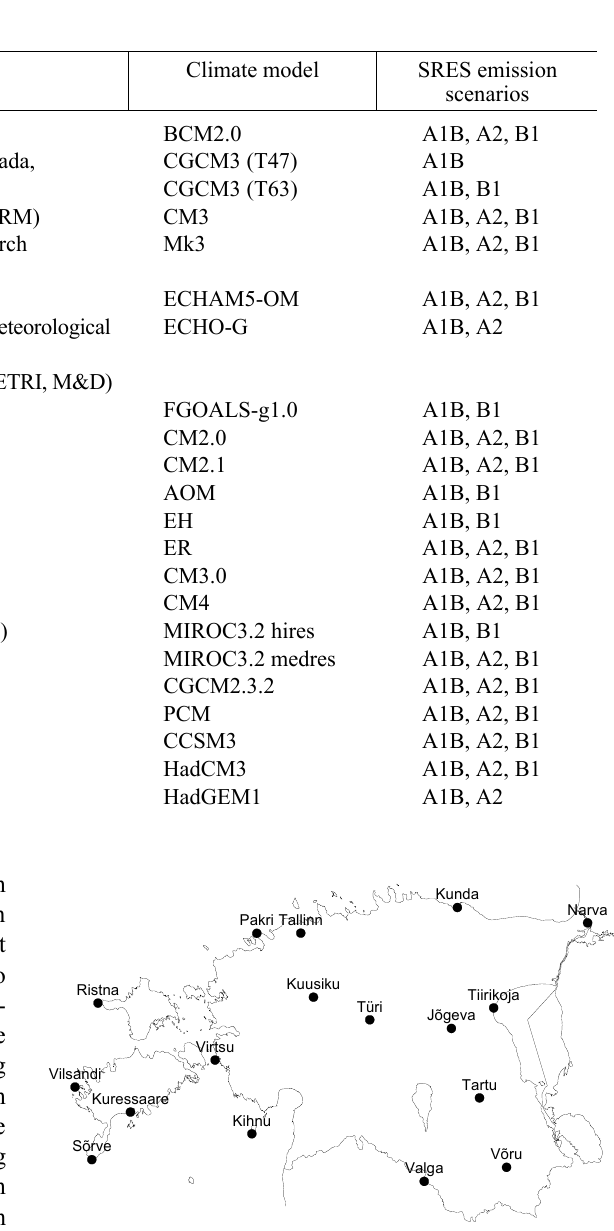
Fig. 1. Location map of meteorological stations used in this study.